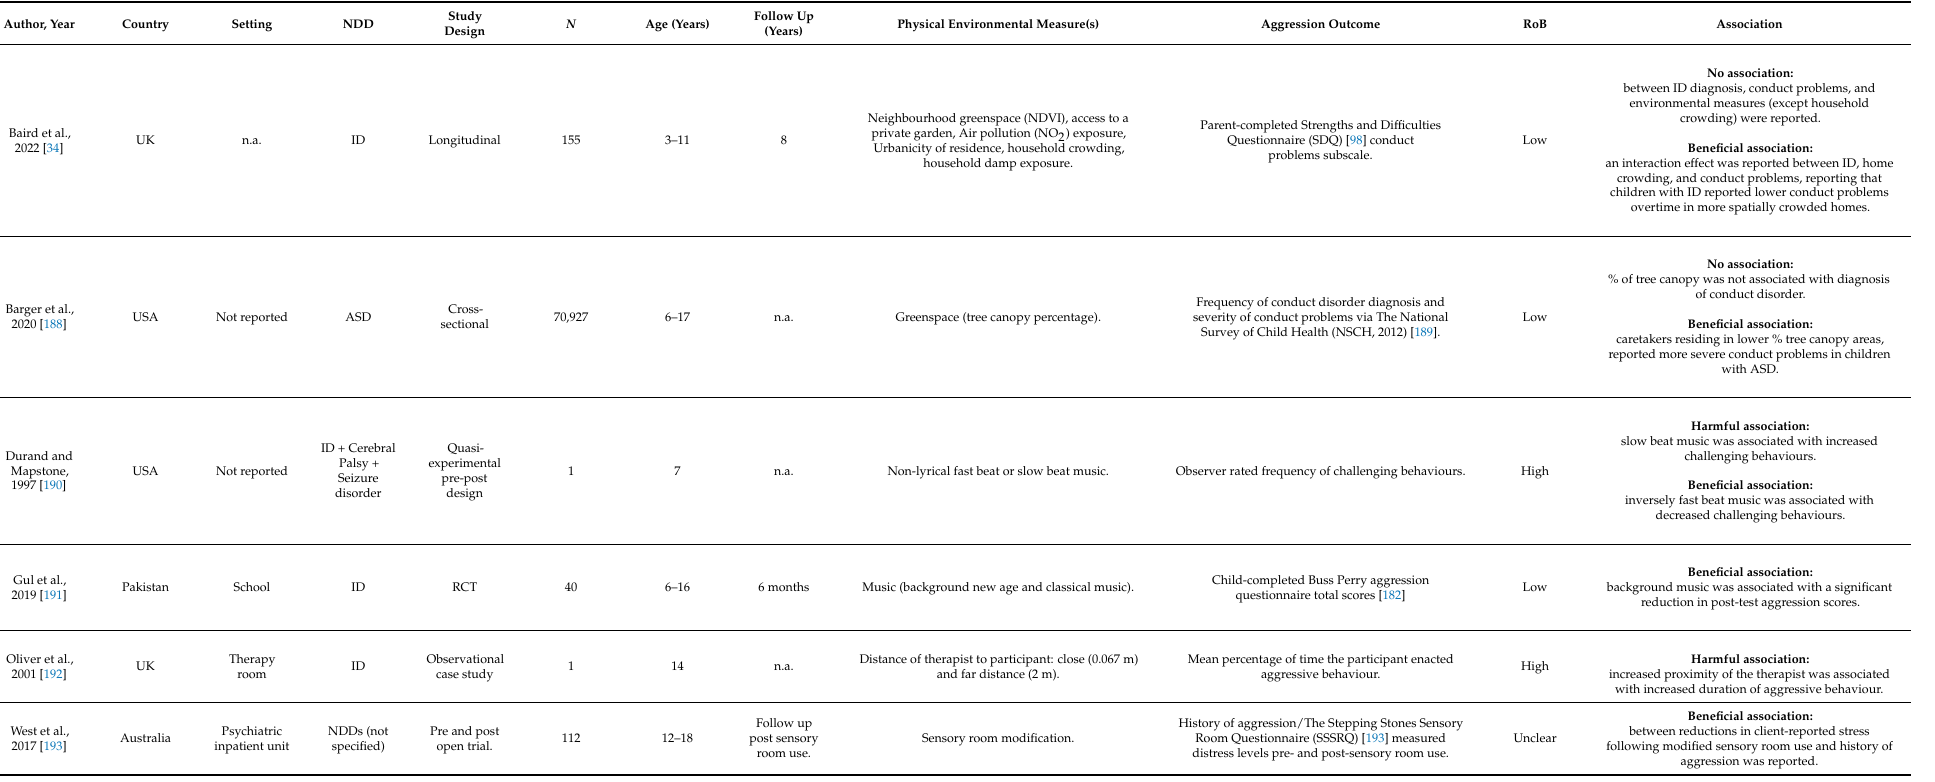
Table 2. Risk of bias (RoB) summary for studies reporting on environmental domains and aggressive behaviours in neurodiverse